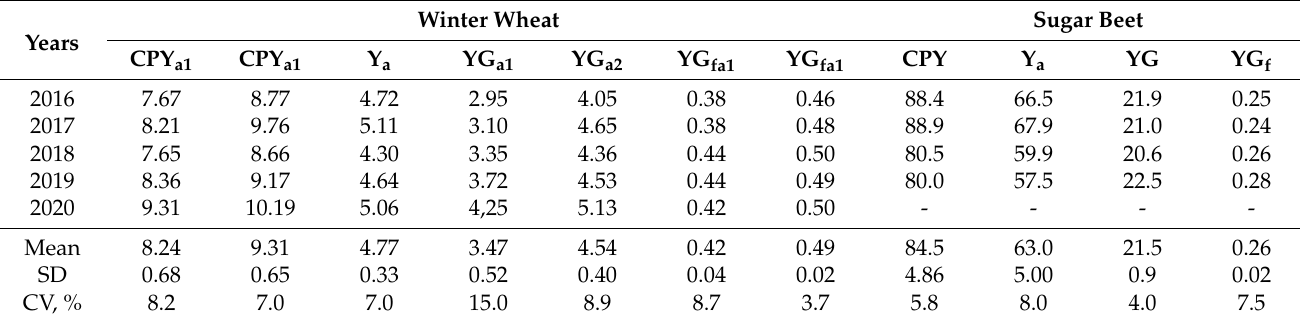
Table 1. The Climatic Yield Gap for basic seed crops in Poland, t ha − 1